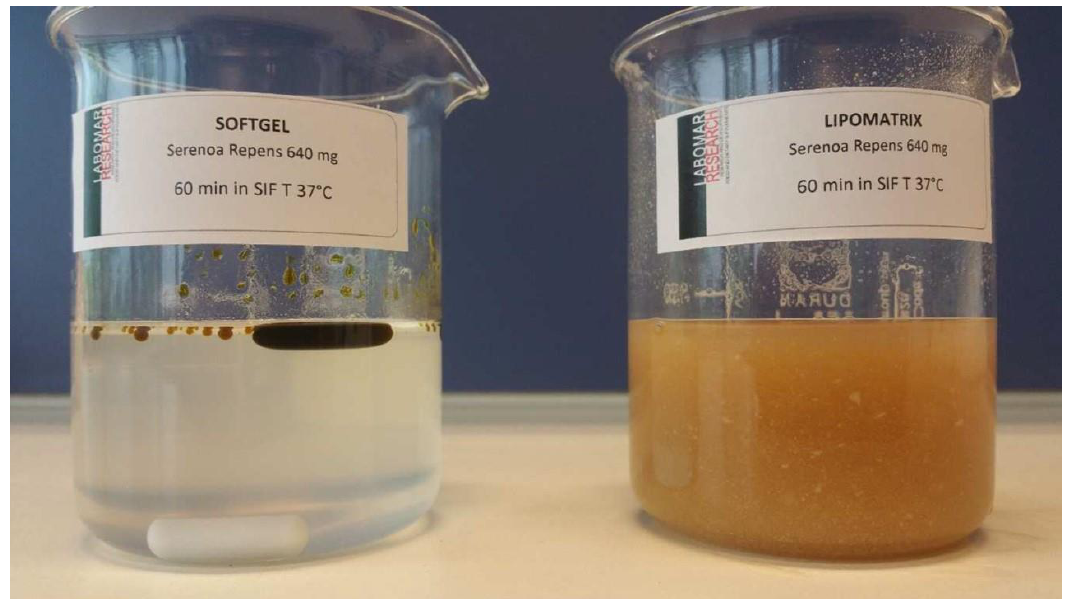
Figure 5. Differential behavior in FaSSIF-V2 at 37 °C, 60 min. of 2 gelatin based soft-gel containing not formulated SRO, 640 mg (left) and Lipomatrix powder containing the same amount of SRO (right). It is possible to recognize the emulsifying capability of Lipomatrix in comparison with soft-gel in which no apparent emulsification occurs. Some insoluble particles suspended in FaSSIF-V2 and ascribable to insoluble excipients such as Magnesium Stearate and amorphous silica are appreciable.